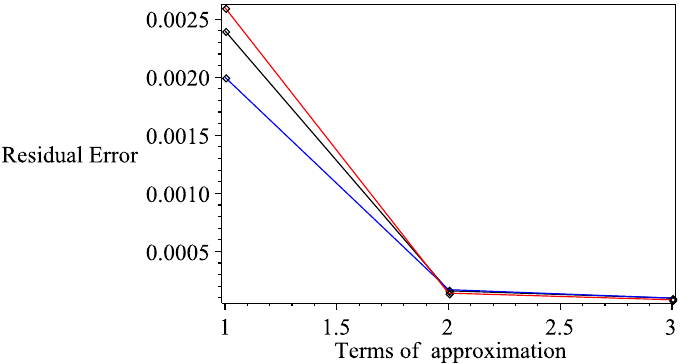
Fig. 10 Plot of Residual Error function verses Terms of approximation , where Curve 1 has Le = 2, Nb = 2, Pr = 1, Nt = 1, n = 0 . 5, Curve 2 has Le = 3, Nb = 1, Pr = 5, Nt = 0, n = 1, and Curve 3 has Le = 2, Nb = 2, Pr = 7, Nt = 0 . 5, n = 0 . 8 using their respective error-minimizing convergence control